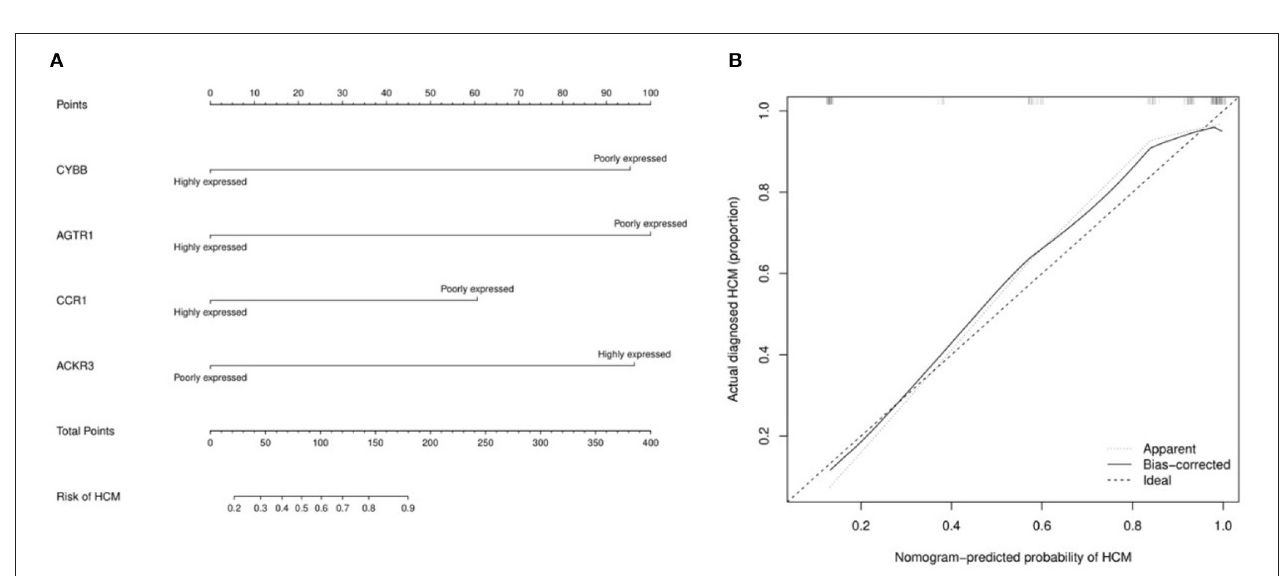
FIGURE 7 | The miRNA—feature IRG regulatory network and transcription factor (TF)—feature IRG regulatory network. (A) The miRNA—feature IRG regulatory network. (B) The transcription factor (TF)—feature IRG regulatory network.